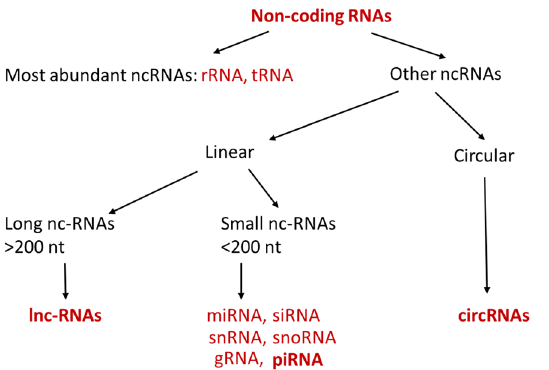
Figure 1. Types of ncRNAs. ncRNAs can be categorized into linear (long and small) and circular ncRNAs. ncRNAs in bold are discussed in the below sections.